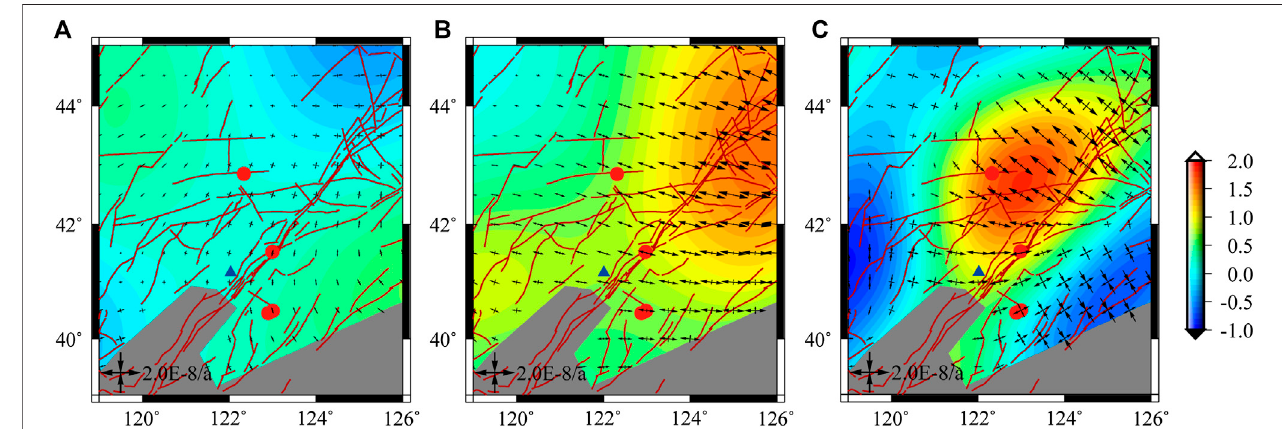
FIGURE 8 | Global Positioning System (GPS) main strain rate fi elds and area strain rate fi elds. Results for (A) 1999 – 2007, (B) 2011 – 2013, and (C) 2013 – 2016. Arrowsdenotethemainstrainrate fi eldsandthecolorbasemapdenotestheareastrainrate fi elds.ThebluetriangledenotesthePanjingobservationwell;theredcircles denote earthquake epicenters, as in Figure 1 .